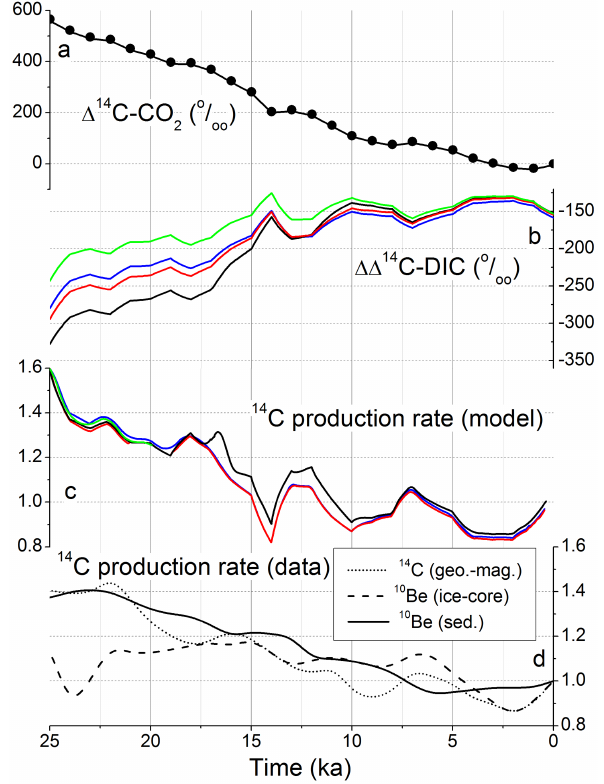
Figure 12. Radiocarbon values and production rates. (a) Atmo- spheric (cid:49) 14 C-CO 2 ; dots are IntCal13 data (Reimer et al., 2013) while the black line shows the values applied in the model runs. (b) Marine (cid:49)(cid:49) 14 C-DIC values calculated as difference between radiocarbon in seawater DIC and atmospheric CO 2 . The results of simulations STD-CC-CN, STD-CC, and STD are indicated as blue, red, and black lines, respectively. The green line indicates the re- sults obtained in a steady-state simulation under Holocene boundary conditions where all variables except atmospheric (cid:49) 14 C-CO 2 and radiocarbon production rate were kept constant over time. (c) Pro- duction rates of radiocarbon in the atmosphere calculated in the model runs and normalized to the pre-anthropogenic modern value (1.64atomscm 2 s − 1 ). (d) 14 C production rates calculated from the geo-magnetic record (Laj et al., 2002); 10 Be production rate as re- constructed from Greenland ice-core data (Muscheler et al., 2005; Reimer et al., 2013), 10 Be production rate as reconstructed from sed- iment data (Frank et al., 1997); all rates are normalized to their pre- anthropogenic modern values.